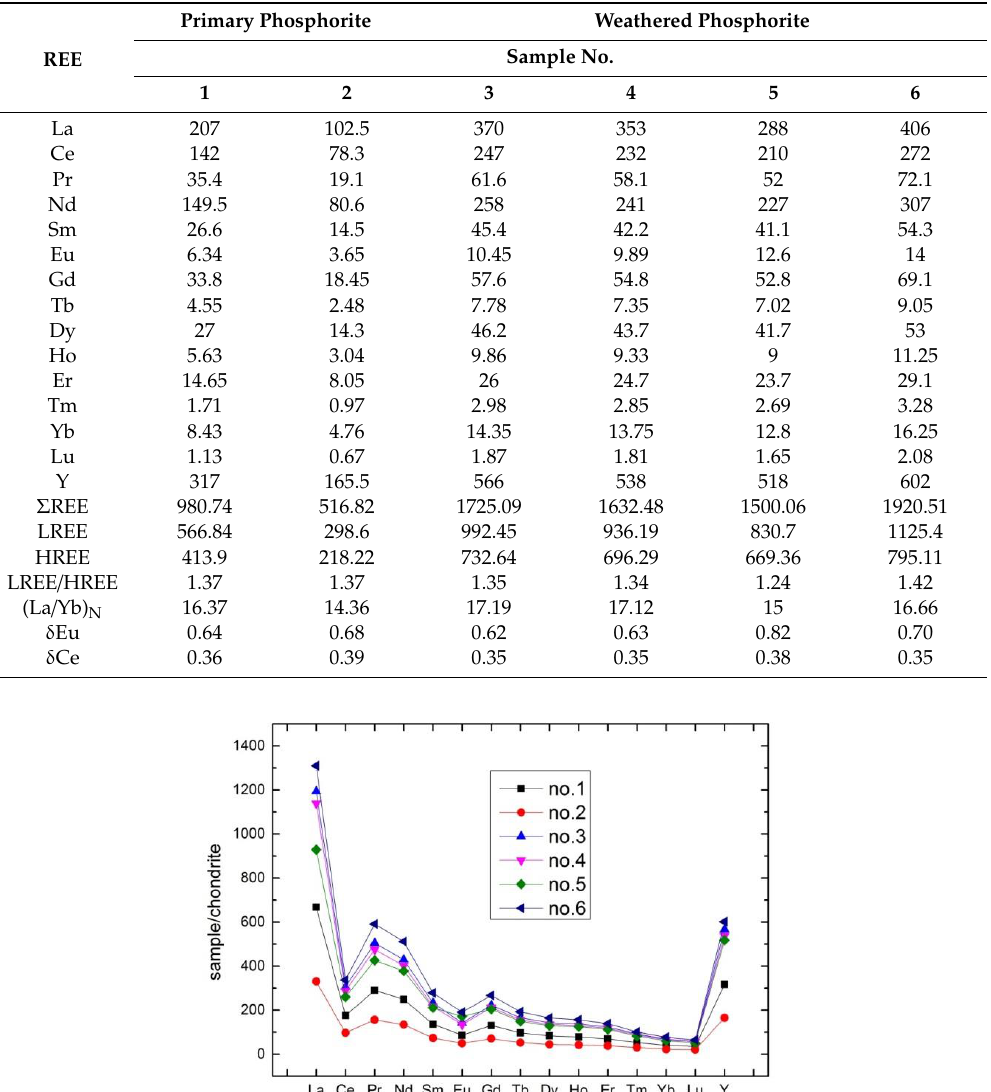
Table 2. Rare earth elements(ppm) of phosphorite.